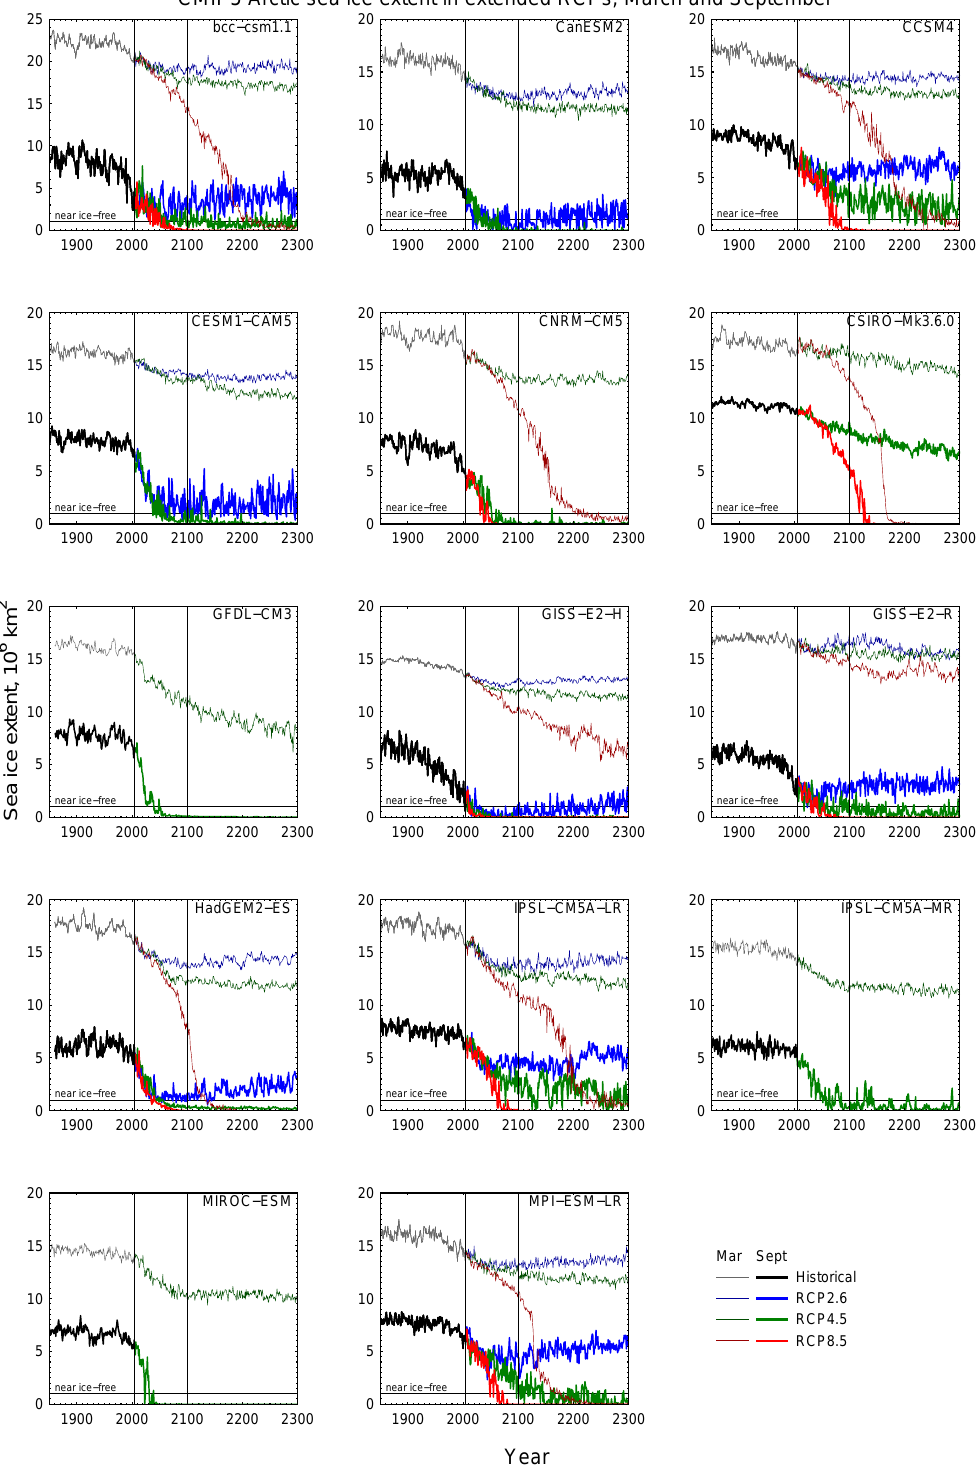
Figure 3. For each model, the time series of Arctic sea ice extent, 10 6 km 2 , for September and March for each of the historical and RCP scenarios. The time series is calculated as the area of sea ice concentration > 15% on the original model grids. No smoothing is applied. Vertical lines indicate 2005 (the end of the historical period) and 2100. A horizontal line at 1 × 10 6 km 2 shows the threshold for the Arctic being ice-free.